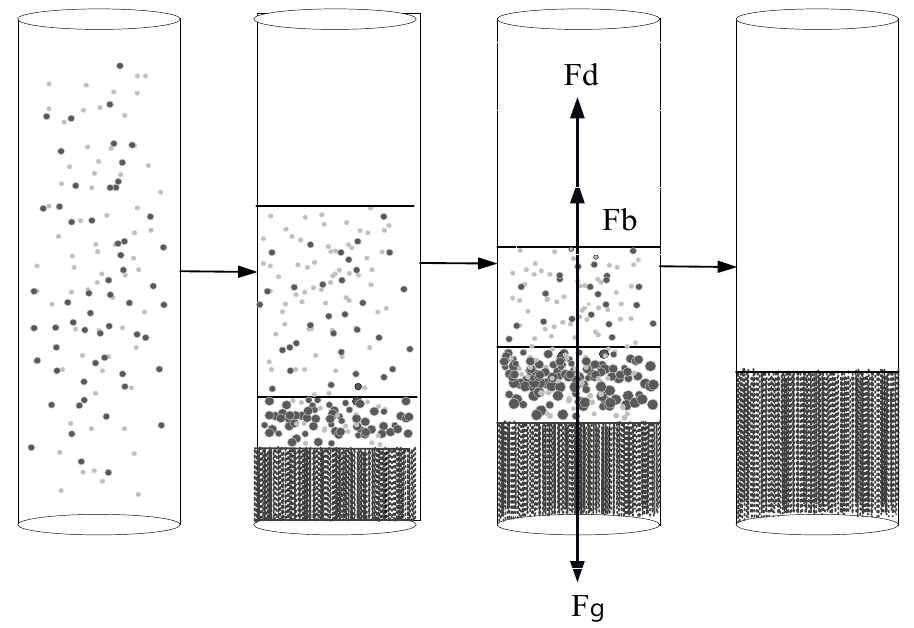
Figure 4. Particle settling process and forces F 𝑔 , F b , and F d .